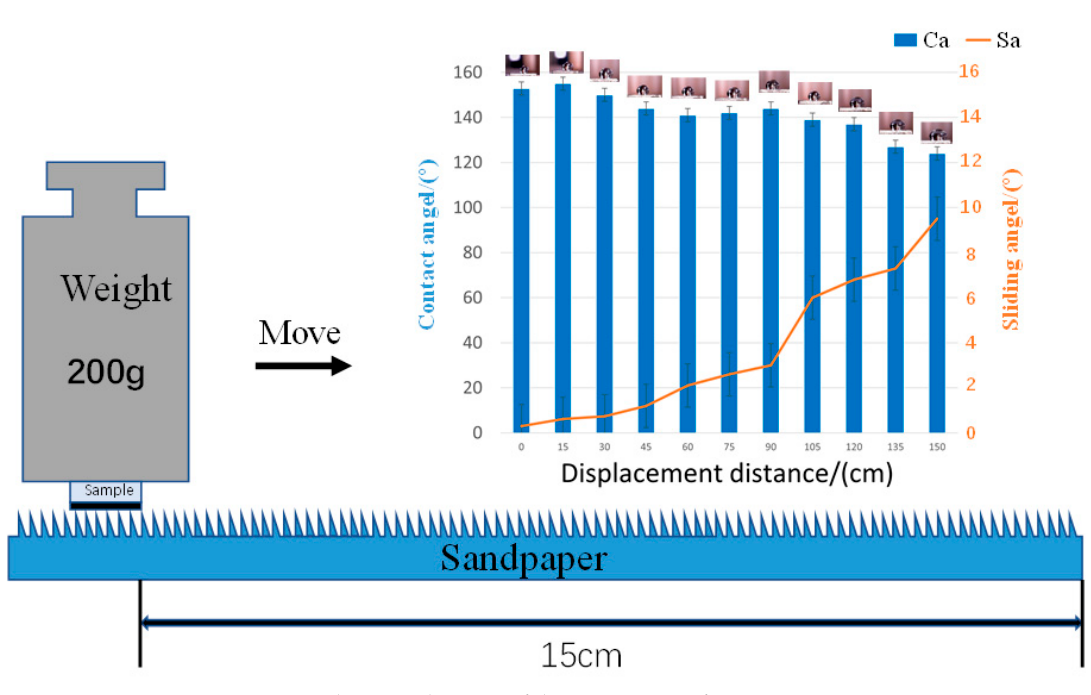
Figure 7. Schematic diagram of the test piece surface wear test.